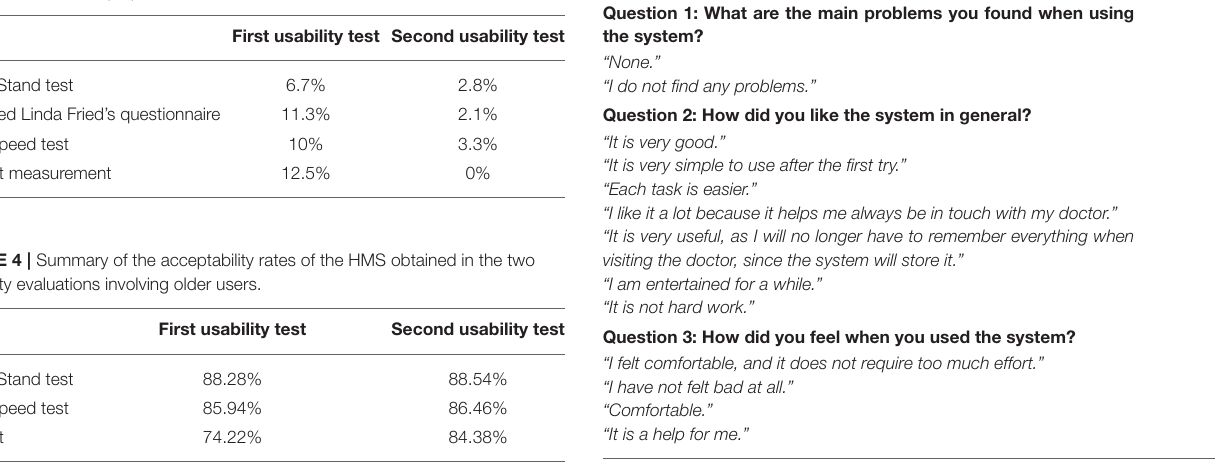
TABLE 3 | Efficiency measurement results: Average deviation with respect to the optimal number of taps per task.